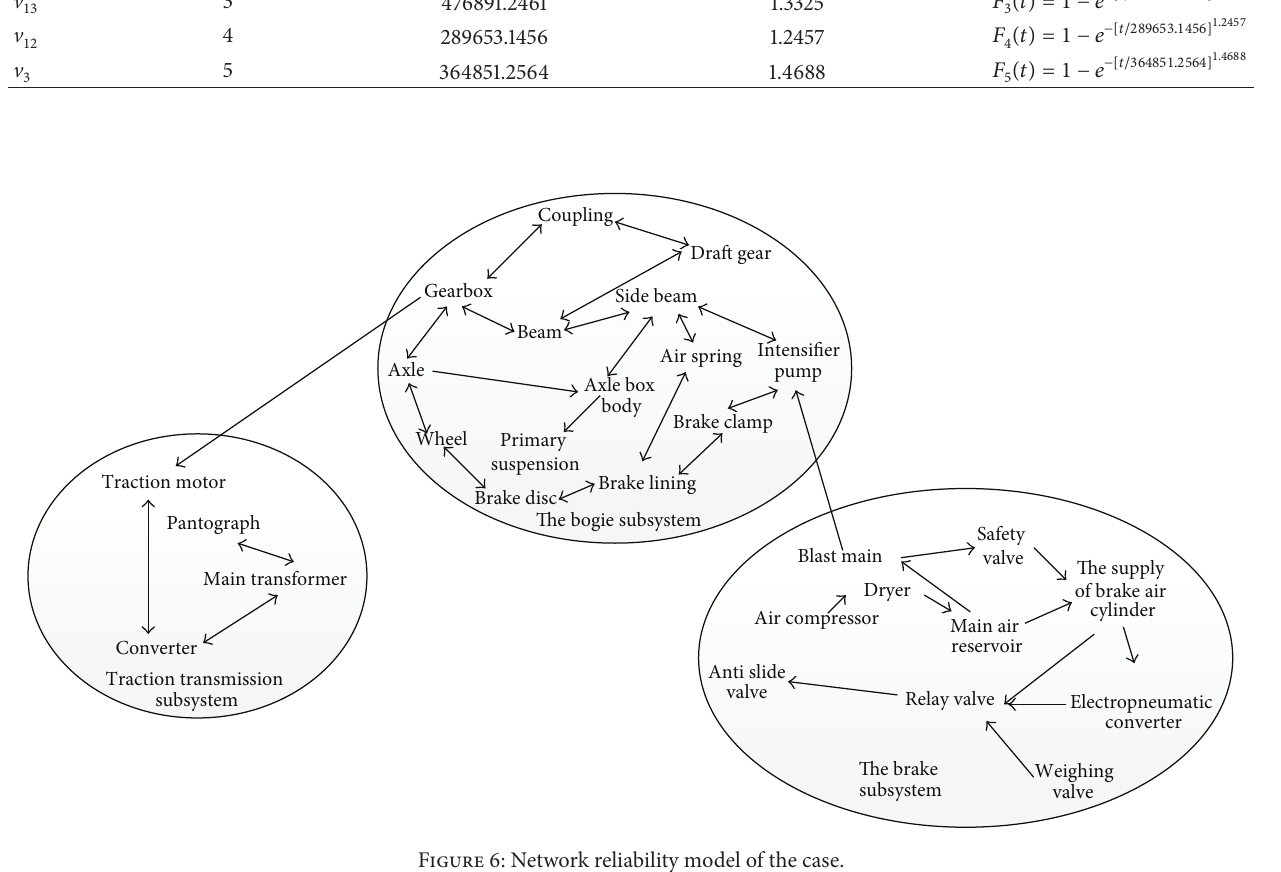
Figure 6: Network reliability model of the case.